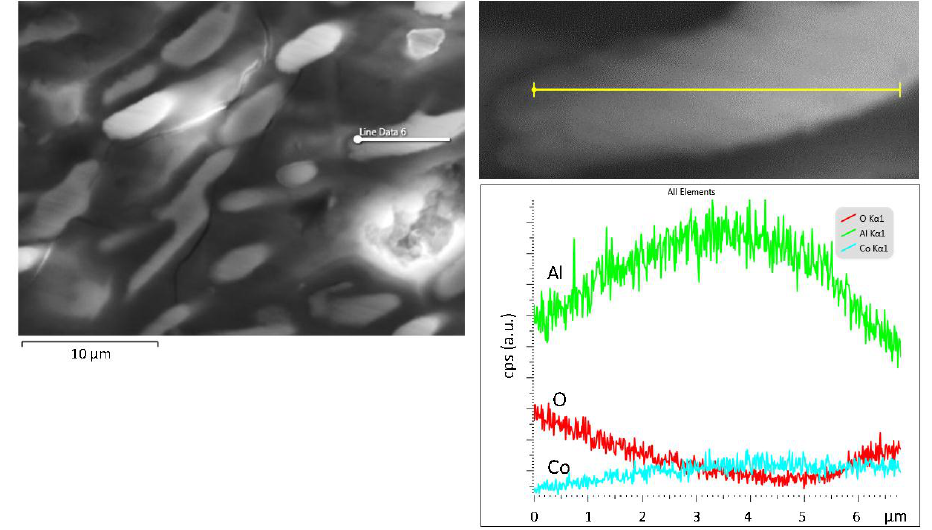
Figure 8. Cross‐section (SE mode) of Al‐7 wt.% Co after cyclic polarization (3.5 wt.% NaCl, 25 °C) and